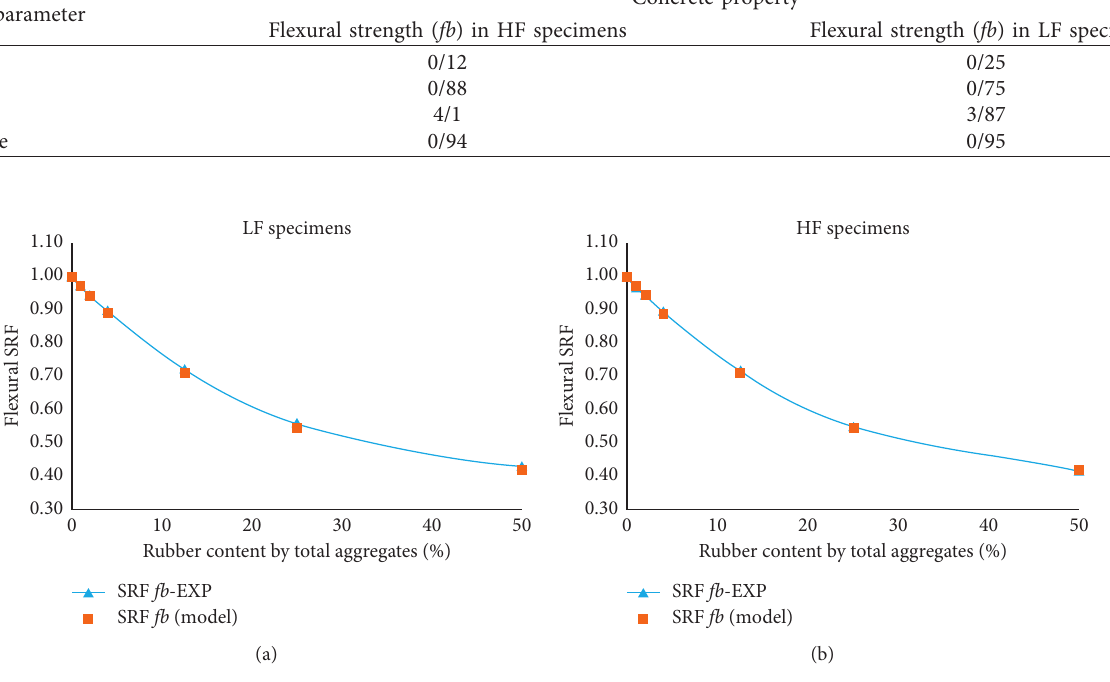
Figure 7: Comparison between experimental results and the proposed model. (a) LF specimens. (b) HF